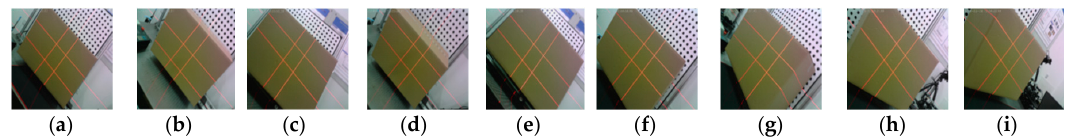
Figure 18. Images of nine different poses; ( a ) vertical shooting; ( b ) tilt 30° to the left; ( c ) tilt 60° to the left; ( d ) tilt 30° to the right; ( e ) tilt 60° to the right; ( f ) tilt 30° upward; ( g ) tilt 60° upward; ( h ) tilt 30° downward; and, ( i ) tilt 60° downward. Table 3. Error analysis of the measurement results of nine different poses for 30 times.